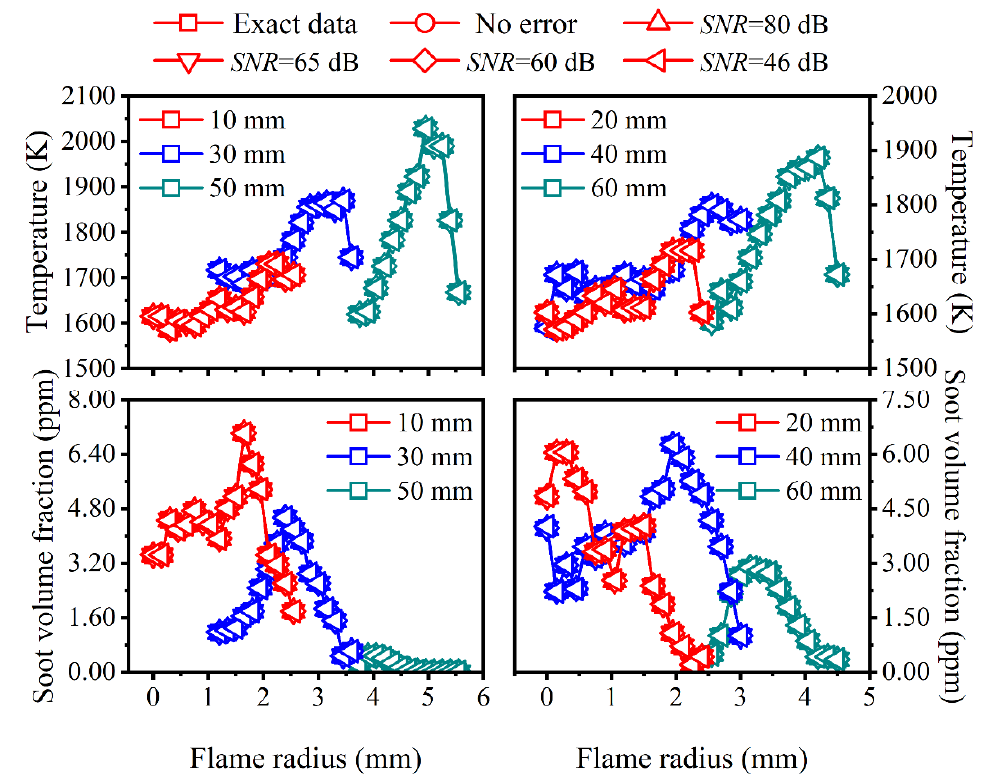
Figure 17. The reconstructed flame temperature and soot volume fraction at main cross-sections in the sooting regions using the ray number 228.